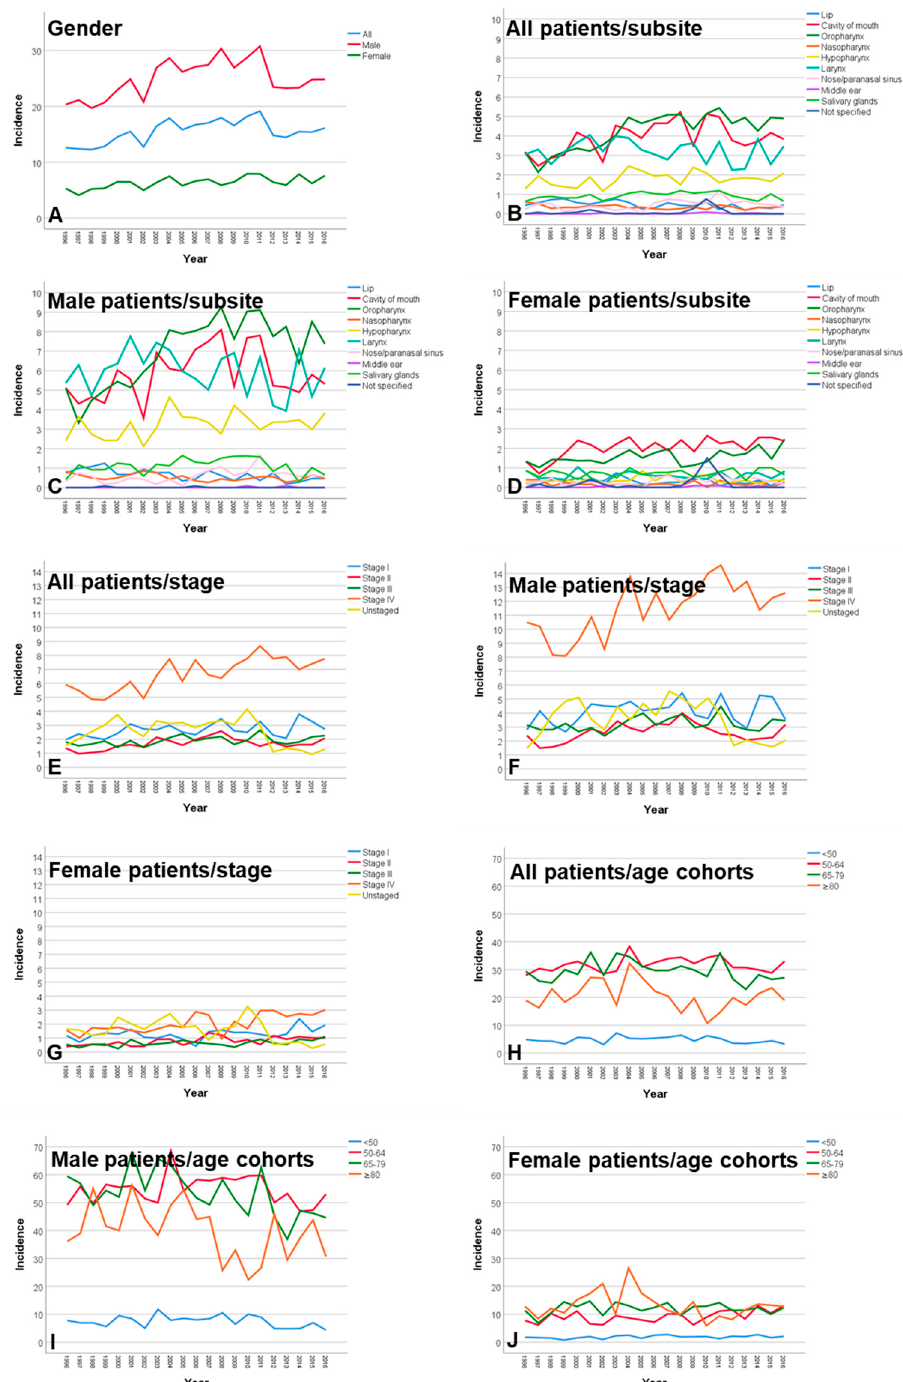
Figure 3. Incidence rates of head and neck cancer per 100,000 population in Thuringia per year from 1996 to 2016. ( A ) Related to gender. ( B ) Related to subsite in all patients. ( C ) Related to subsite in male patients. ( D ) Related to subsite in female patients. ( E ) Related to tumor stage in all patients. ( F ) Related to tumor stage in male patients. ( G ) Related to tumor stage in female patients. ( H ) Related to age groups in all patients. ( I ) Related to age groups in male patients. ( J ) Related to age groups in female patients.